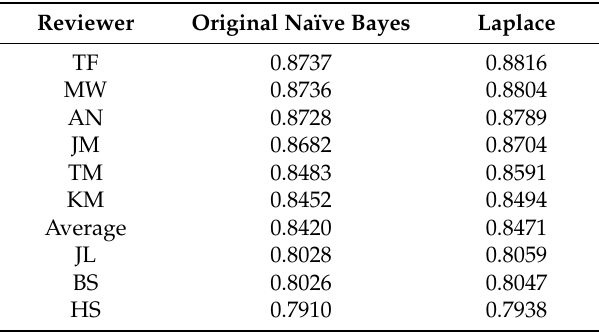
Table 5. Reviewers by order of Naïve Bayes accuracy.